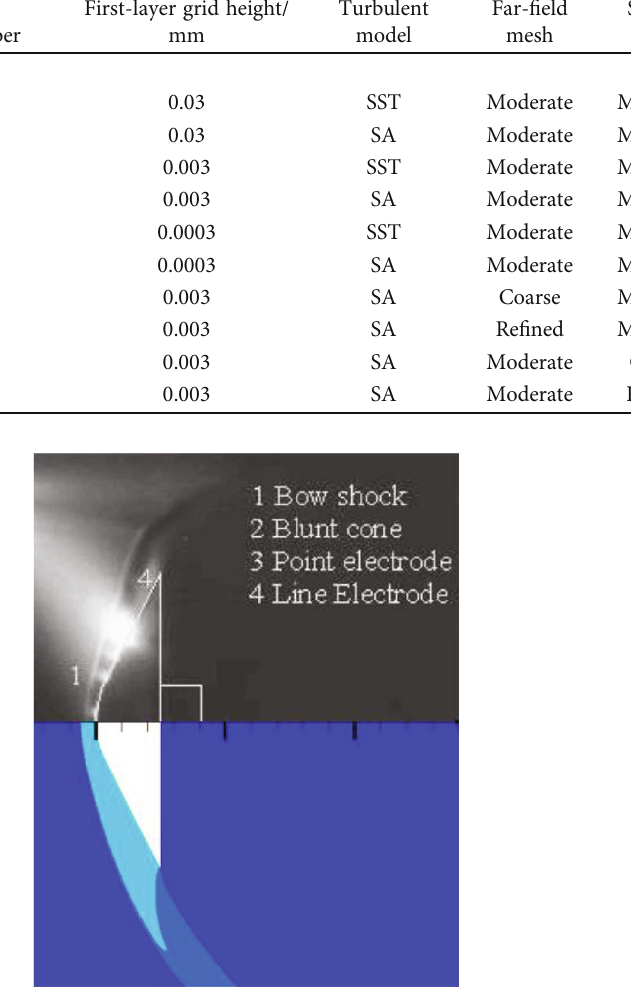
Figure 5: Comparison between the numerical contour and experimental schlieren picture.